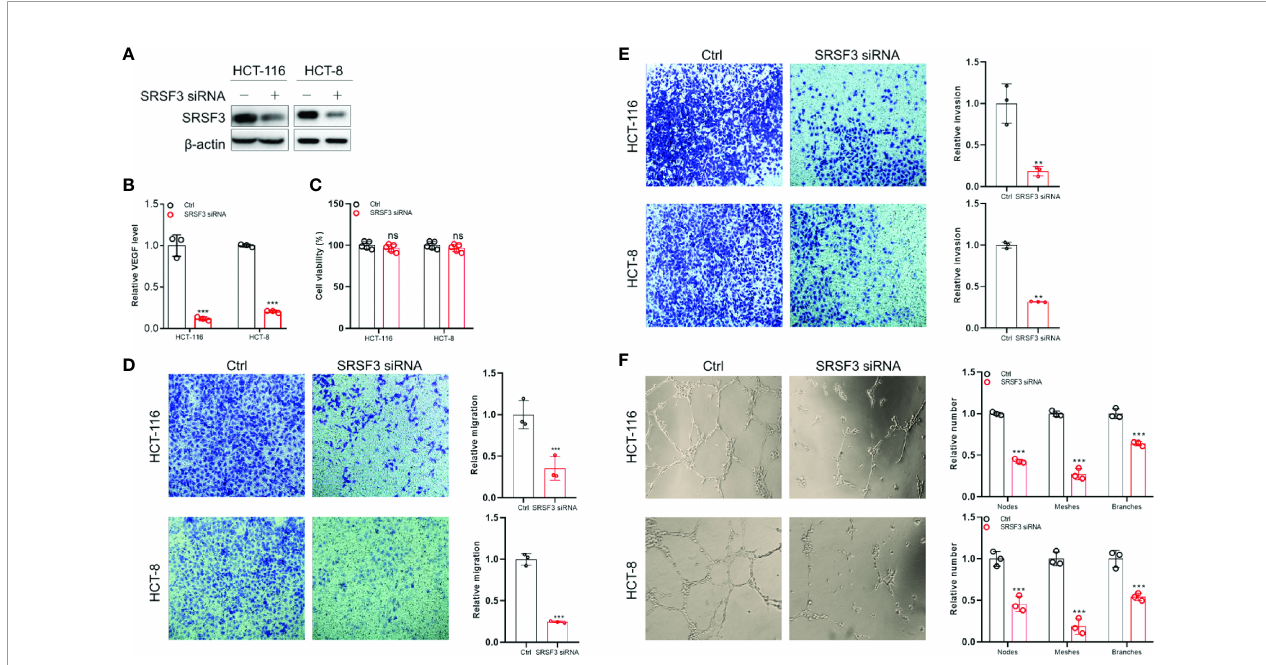
FIGURE 4 | The SRSF3-promoted angiogenesis in CRC. (A) Western blotting for evaluating SRSF3 siRNA in HCT-116 and HCT-8 cells. (B) ELISAs for detecting the effect of SRSF3 siRNA on VEGF secretion in HCT-116 and HCT-8 cells ( n =3). (C) MTT assays to investigate the effect of CM from SRSF3-silenced HCT-116 and HCT-8 cells on the proliferation of HUVECs ( n =6). (D) Transwell assays for investigating the effect of CM from SRSF3-silenced HCT-116 and HCT-8 cells on the migration of HUVECs ( n =3). (E) Transwell assays for investigating the effect of CM from SRSF3-silenced HCT-116 and HCT-8 cells on the invasion of HUVECs ( n =3). (F) The effects of CM from SRSF3-silenced HCT-116 and HCT-8 cells on the tube formation of HUVECs ( n =3). Data represent mean±SD. Signi fi cance was assessed by two-sided t test. *** P <0.001; ** P <0.01; ns, no signi fi cance.